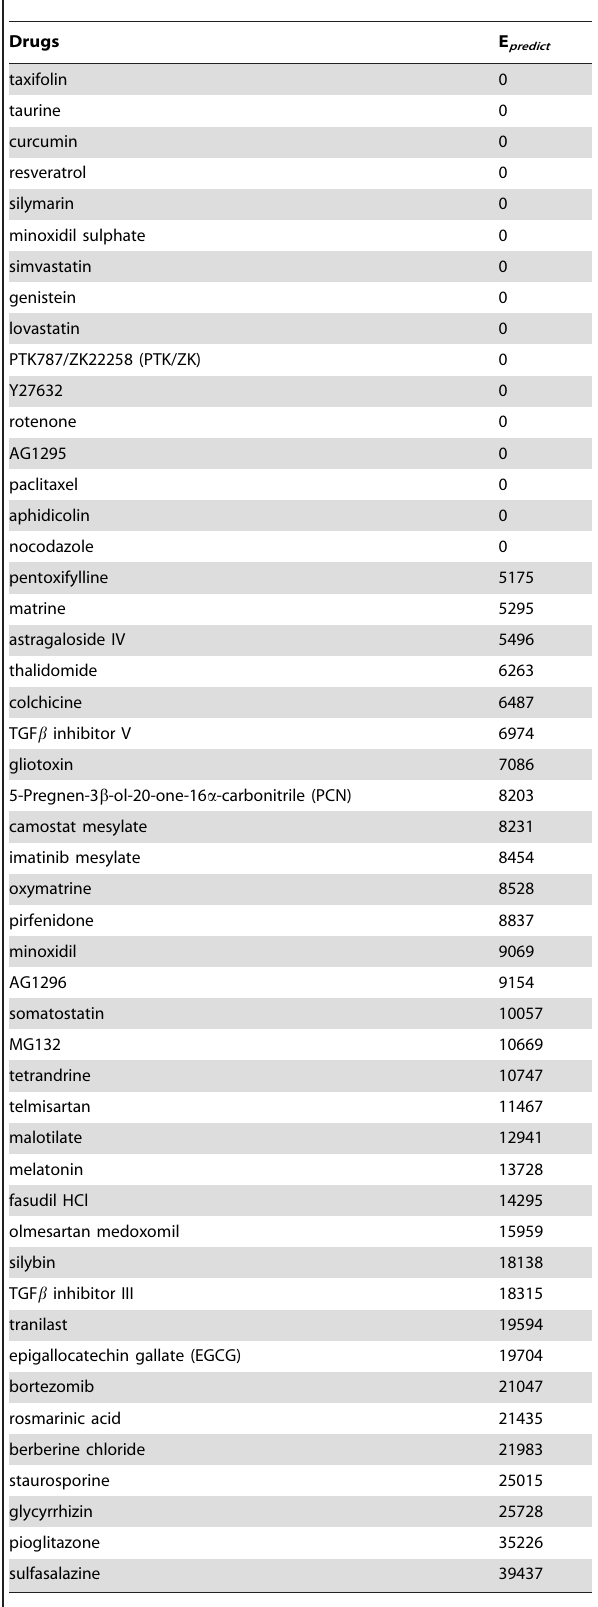
Table 2. List of E predict values for all the drugs.